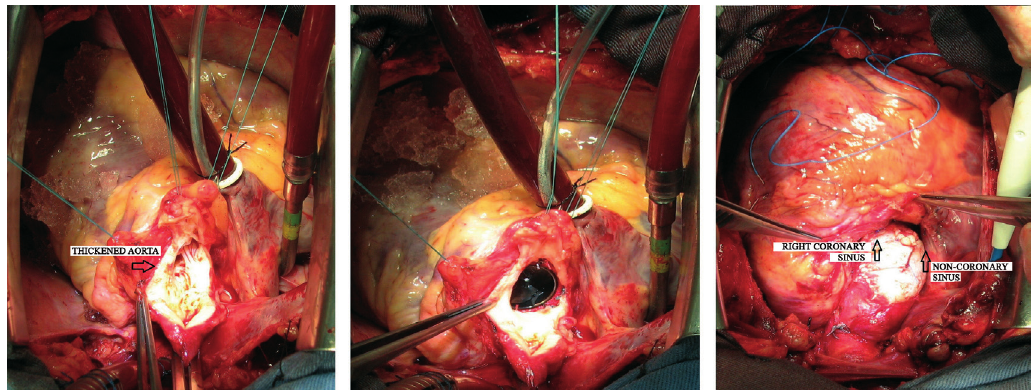
Fig. 2 - Images from the surgery. Aortotomy in inverted “Y”, thickened aorta. Mechanical aortic prosthesis positioned. Final external appearance, with a pericardial patch extending to the right coronary and non-coronary